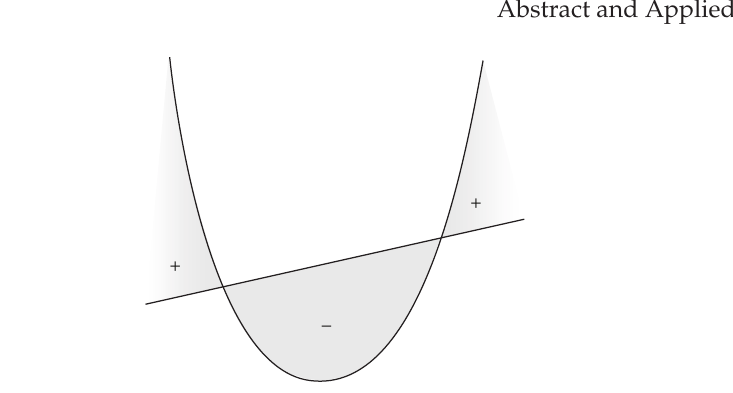
Figure 1: Graphic concept of Jensen’s